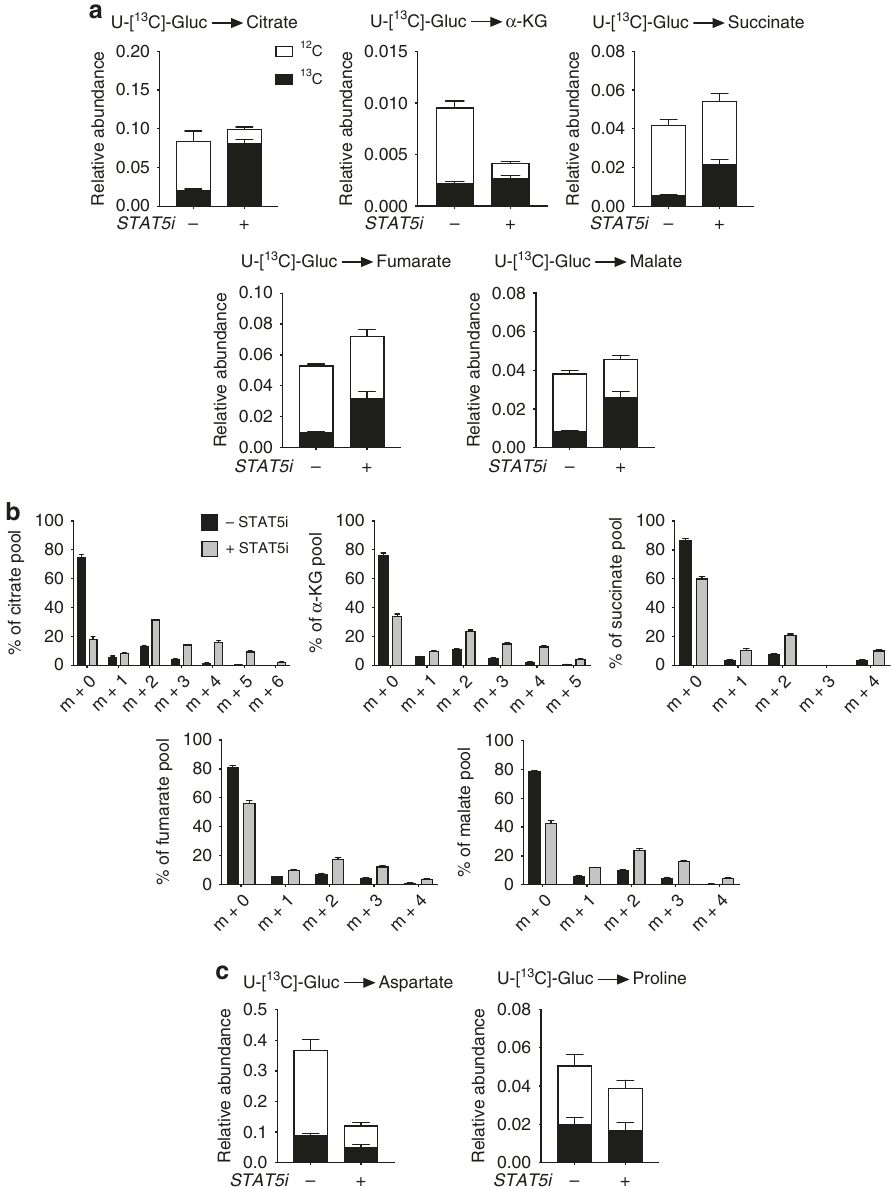
Fig. 7 Disrupted glutaminolysis causes compensatory TCA cycling. a NV T-cells were activated (anti-CD3/CD28) in the presence or absence of STAT5i (100 μ M) for 4 h. Relative abundance of glucose-derived 12 C and 13 C TCA cycle metabolites citrate, α -ketoglutarate, succinate, fumarate and malate. b Mass isotopologue distributions (MID) of TCA cycle intermediates citrate, α -ketoglutarate, succinate, fumarate and malate. c Relative abundance of glucose-derived 12 C and 13 C amino acids aspartate and proline. Data are representative of four experiments and are expressed as mean +